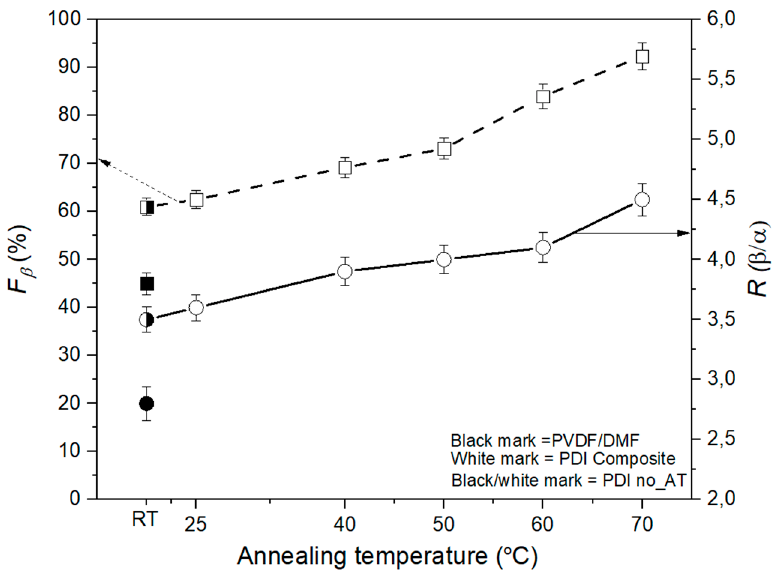
Figure 4. Fraction of β -phase F and ratio R ( β / α ) vs. annealing temperature.